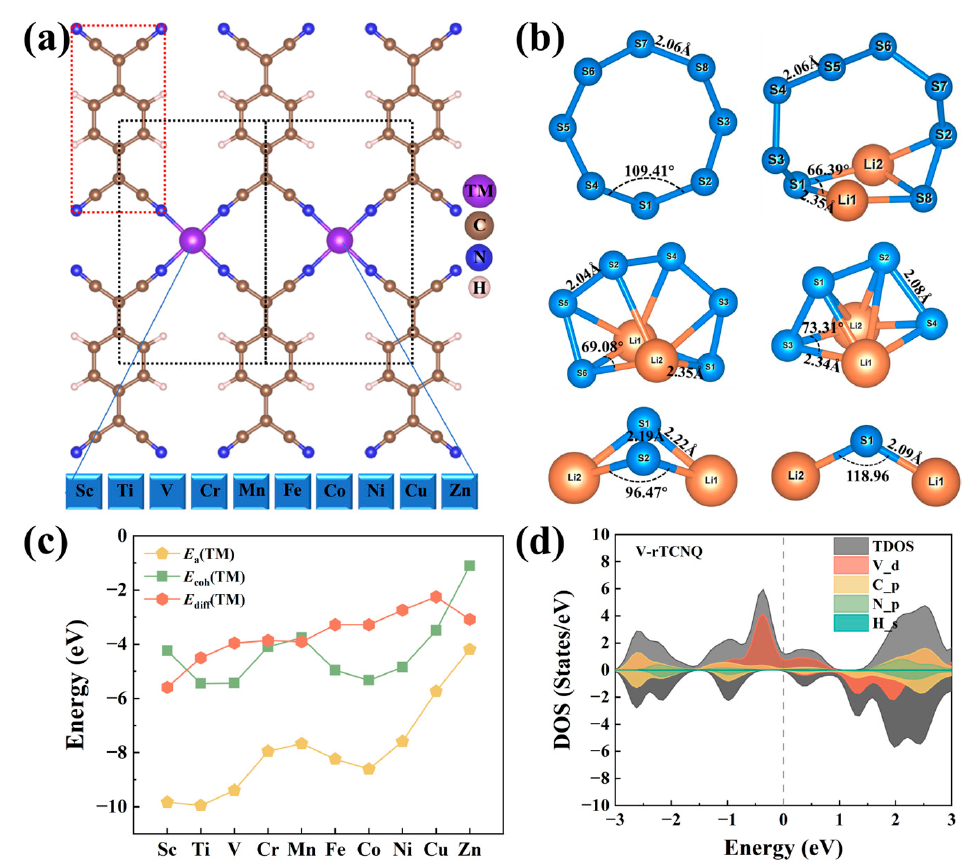
Figure 1. ( a ) Schematic diagram of TM-rTCNQ (TM = Sc, Ti, V, Cr, Mn, Fe, Co, Ni, Cu and Zn) geometric structures (the red and black rectangle boxes represent the TCNQ molecule and unit cell of TM-rTCNQ, respectively). ( b ) Fully optimized S 8 /LiPSs molecules and some structural parame-ters are marked at corresponding positions. ( c ) The calculational results of adsorption energies ( Ea ), cohesive energies ( E coh ) and E dif f ( E a − E coh ) of TM-rTCNQ. ( d ) The DOS diagram of V-rTCNQ unit cell, including total DOS (TDOS), projected DOS of d orbital of V (V_d), p orbital of C and N (C_p and N_p), as well as s orbital of H (H_s). Fermi-level is at the position of the gray dotted line.